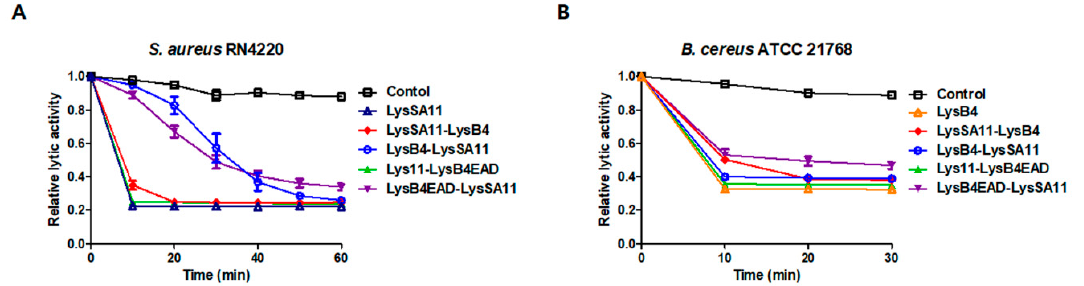
Figure 2. Lytic activity of the hybrid proteins. Relative lytic activity of LysSA11-LysB4, LysB4-LysSA11, LysSA11-LysB4EAD, and LysB4EAD-LysSA11 against ( A ) S. aureus RN4220 and ( B ) B. cereus ATCC 21768 was measured by monitoring a decrease in turbidity compared to their parental endolysins.